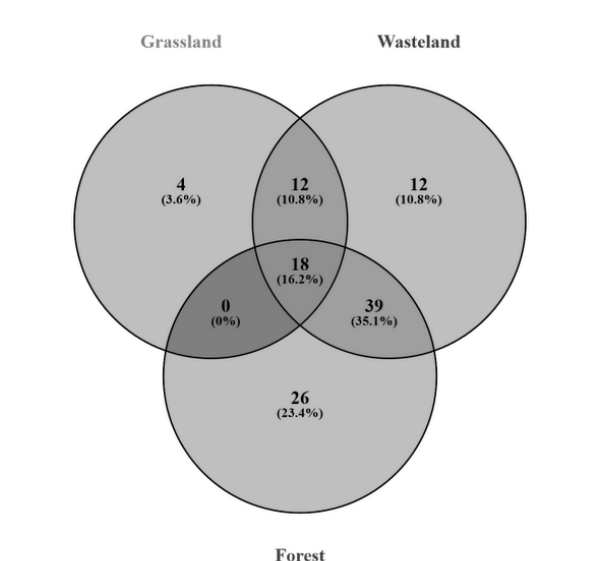
Fig. 6. The diagram showing the number of exclusive species and those common to three vegetation